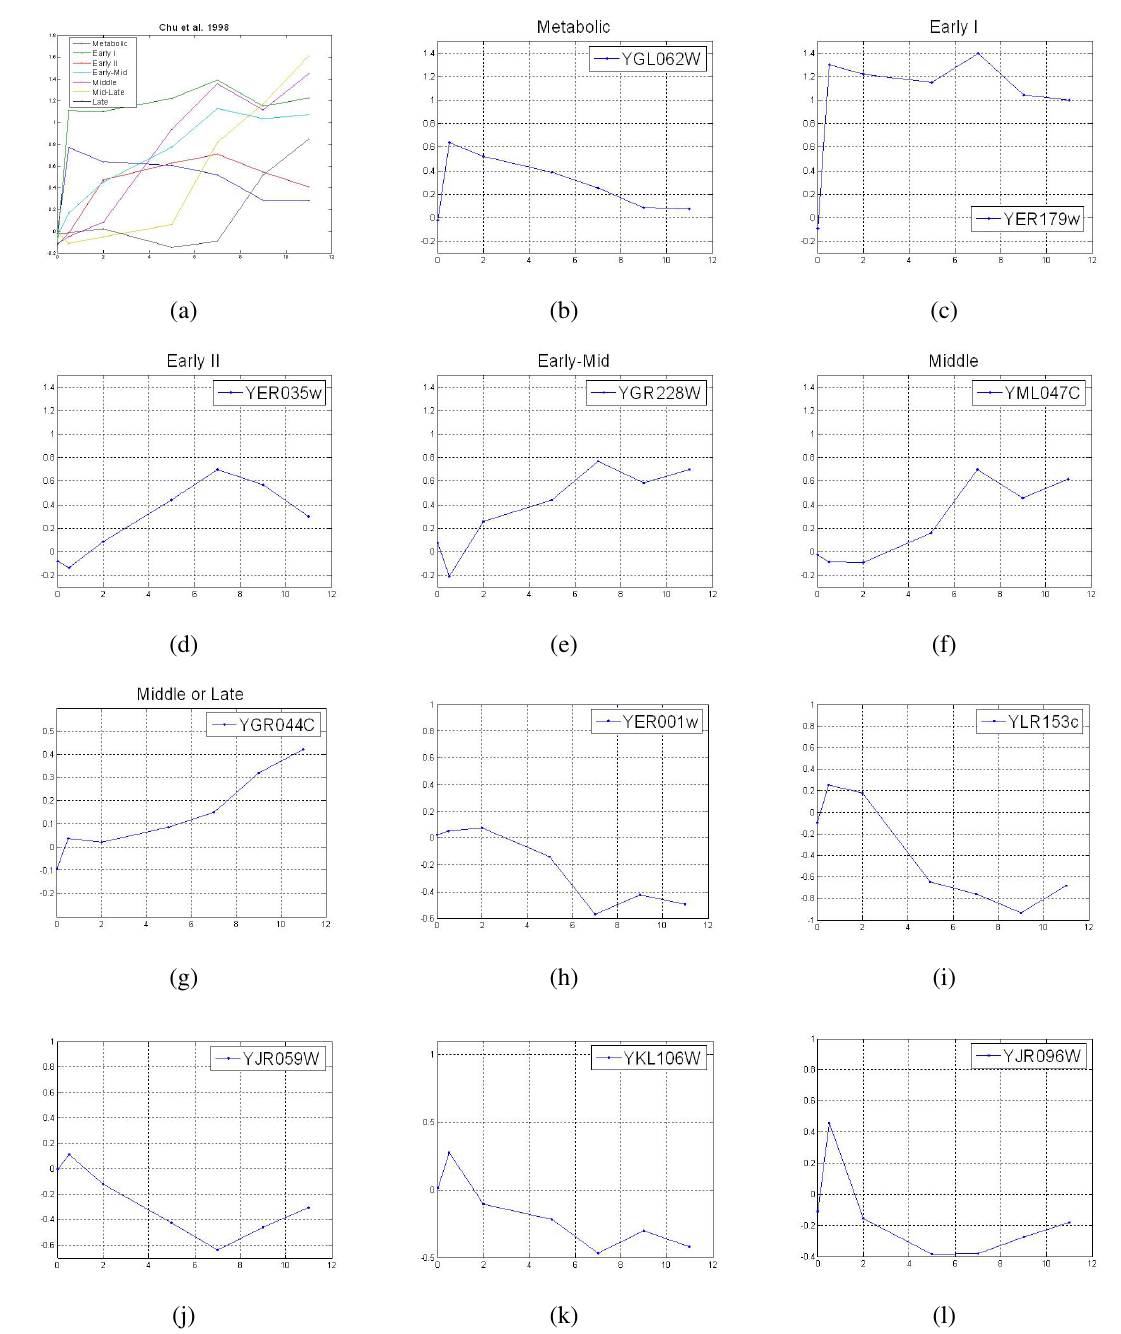
Figure 7: The first 20 distinct patterns we found in yeast data. The left subfigure on the first row shows the seven temporal patterns defined by Chu. et al. [2]. Distinct patterns which have the best match to the corresponding temporal patterns were shown with a